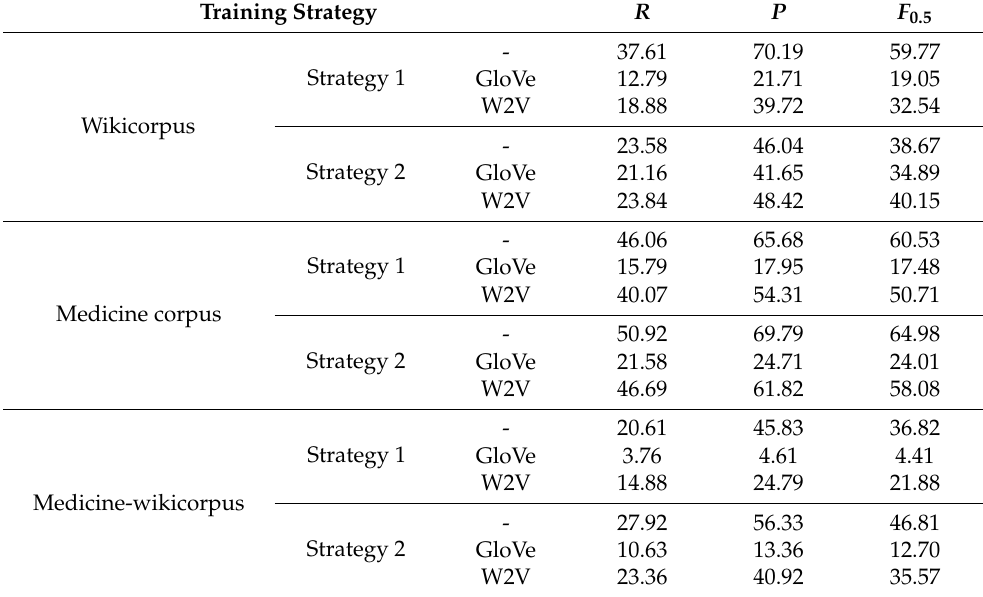
Table 8. Recall ( R ), precision ( P ) and F 0.5 measure for the datasets generated according to the strategies listed in Section 3.3.3 (‘Strategy 1’ and ‘Strategy 2’). The results are shown for the Seq2seq models with GloVe and Word2Vec pretrained embeddings and with no pretrained embedding at all (-). All error types were